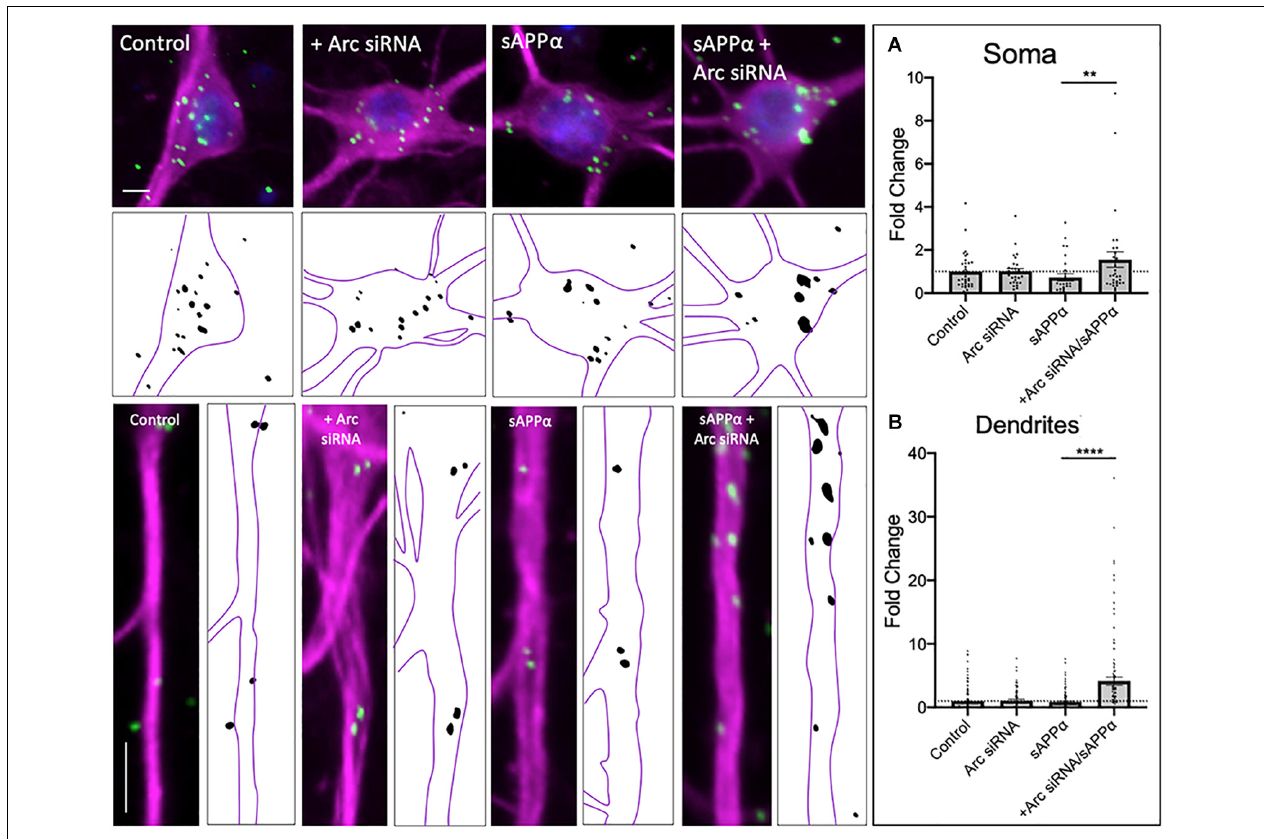
FIGURE 5 | de novo GluA1 persist at the cell surface following siRNA-mediated knockdown of Arc protein. Representative images of somatic (upper panels) and dendritic (lower panels) of control and sAPP α -treated conditions ± treatment with the Arc siRNA. (A) Average data showing treatment with sAPP α (1 nM, 2 h) and Arc siRNA (1 µ M, pre-treatment: 60 min, co-treatment: 2 h) promotes an increase in (A) somatic ( n = 28–35 cells) and (B) dendritic ( n = 79–132) de novo cell-surface GluA1. Outliers were removed from each experiment prior to amalgamation using Grubb’s tests, and normality was detected by D’Agostino and Pearson omnibus normality tests. All data are expressed relative to control, as mean ± SEM from 3 experiments. Data assessing the effect of siRNA are expressed as mean ratio of sAPP α + Arc siRNA/Arc siRNA alone ± SEM. Significance between control and treatment was assessed by student’s t -test, significance between sAPP α -treated and sAPP α + siRNA-treated was assessed by Mann-Whitney two-tailed U-test, ** p ≤ 0.001, **** p ≤ 0.0001. Representative images show neuronal soma (upper panels) and dendrites (lower panels; MAP2, (cid:4) ; GluA1, (cid:4) ; DAPI, (cid:4) ). Scale bars = 10 µ